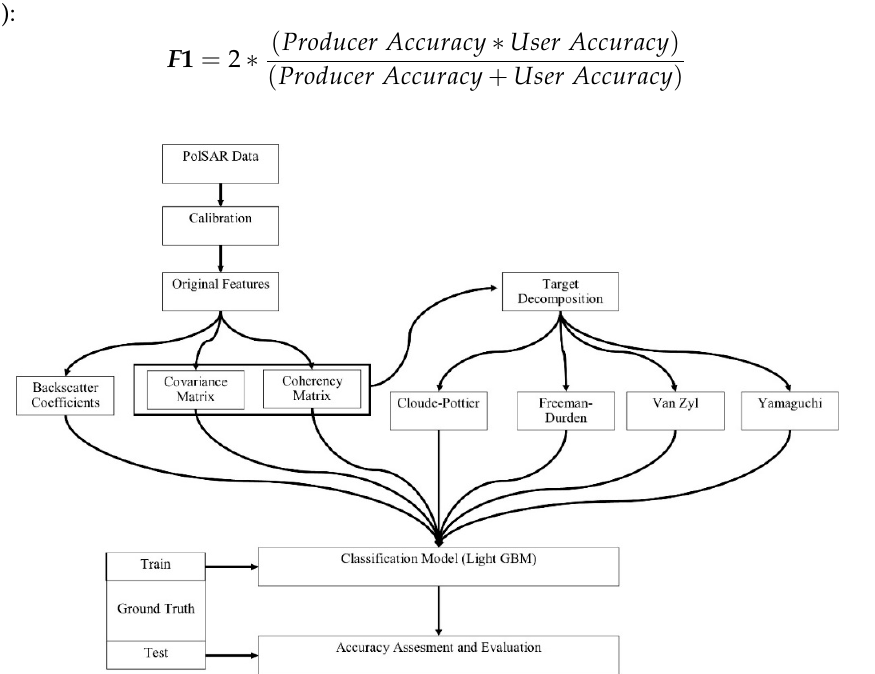
Figure 3. Flowchart of the full polarimetric synthetic aperture radar (PolSAR) data processing.